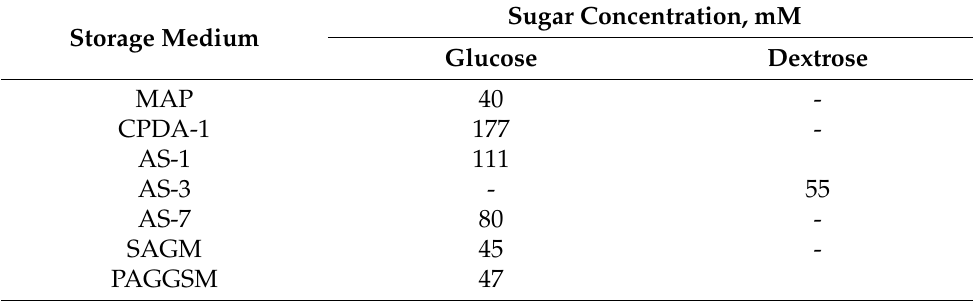
Table 2. Sugar concentration in different storage media